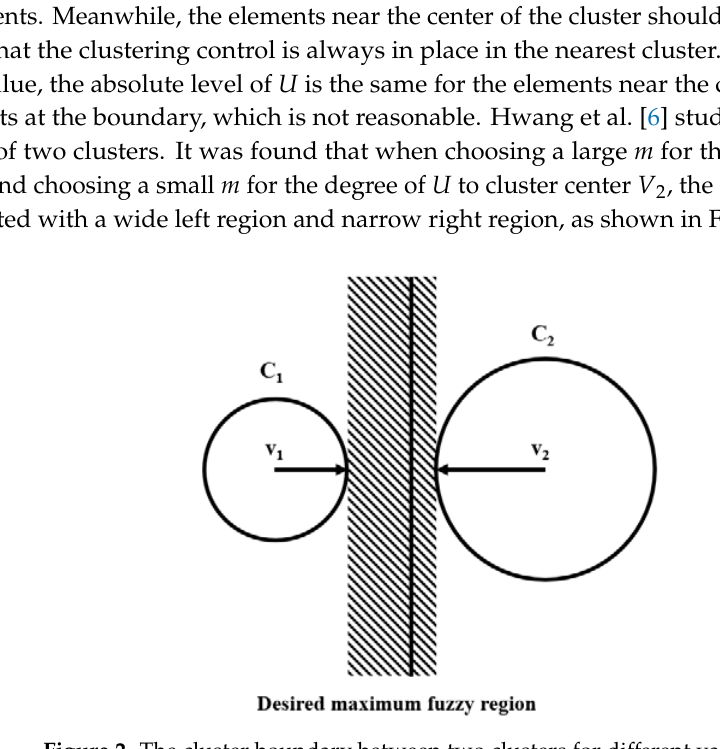
Figure 2. The cluster boundary between two clusters for different values of m.